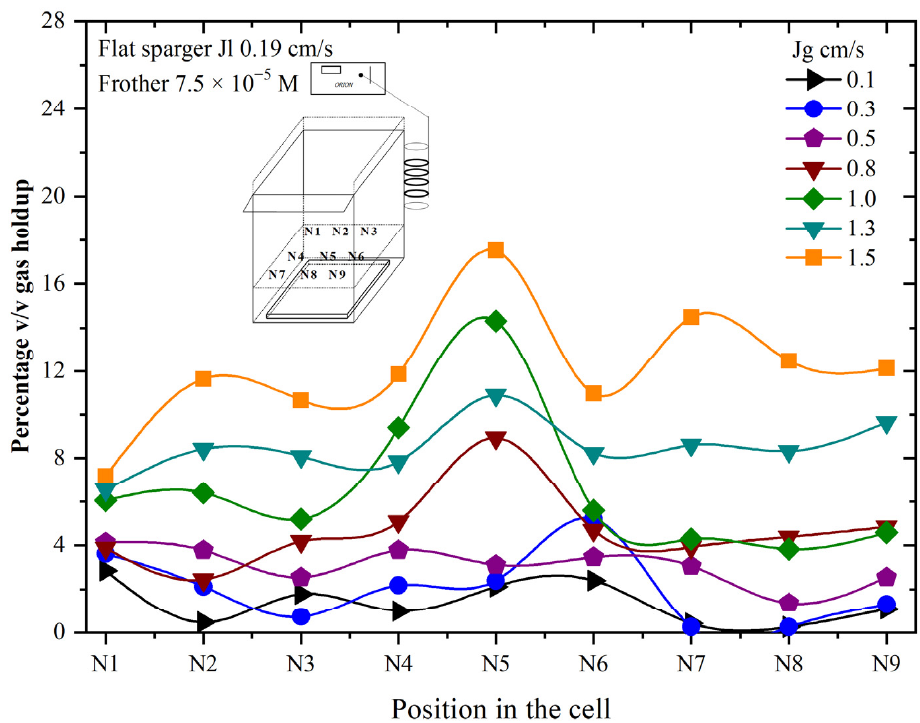
Figure 6. Percentage of v / v gas holdup distribution in the cell flotation, [e] 7.5 × 10 − 5 M, Jl 0.19 cm/s, Jg 0.1 to 1.5 cm/s.